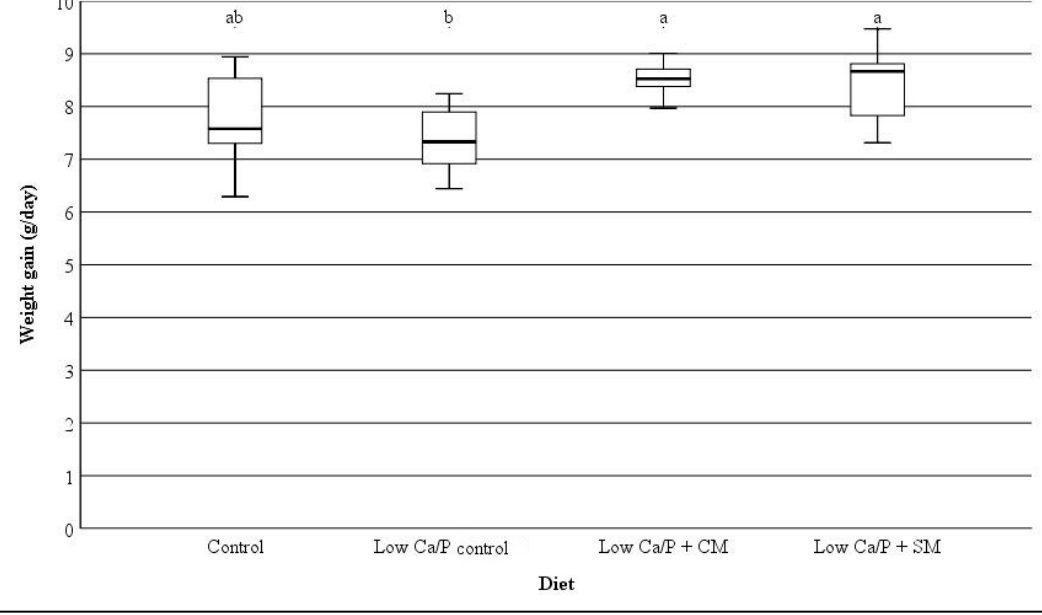
Figure 2. Weight gain (g/day) of rats fed on different milk diets (mean ± standard deviation). Control = rats fed a modified-AIN-93M diet ( n = 9), Low Ca/P control = rats fed a Low Ca/P Modified-AIN-39M diet ( n = 9), Low Ca/P + CM = rats fed a Low Ca/P modified-AIN-93M diet with the addition of cow milk ad libitum instead of drinking water ( n = 15), Low Ca/P + SM = rats fed a Low Ca/P modified-AIN-93M diet with the addition of sheep milk ad libitum instead of drinking water ( n = 15). Different superscript letters indicate significant differences between dietary groups for animal weight gain, determined using repeated measures ANOVA and Tukey’s post hoc testing ( p = 0.008).